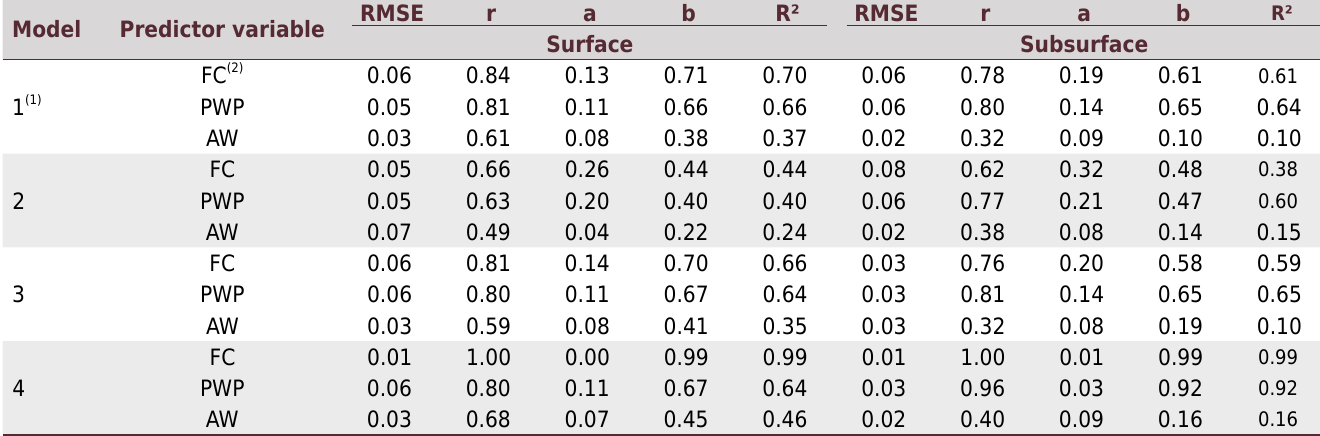
Table 2. Root mean square error (RMSE), correlation coefficient (r), intercept (a), angular coefficient (b), and determination coefficient (R²) between the measured and estimated moisture by multiple linear regressions (MLR) in four models generated with the surface and subsurface horizons database Model Predictor variable